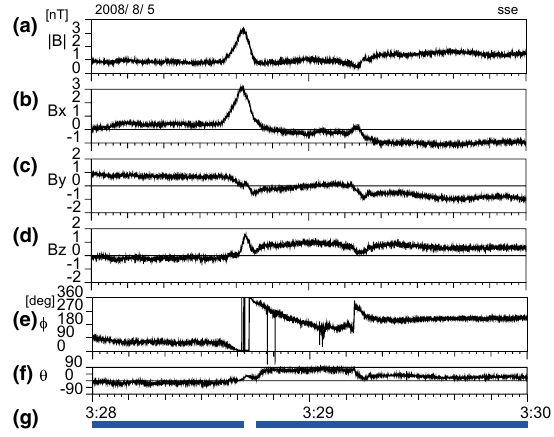
Fig. 8 High time resolution magnetic field of a hot flow anomaly on August 5, 2008. a – d The magnitude and the x SSE , y SSE , z SSE components of the magnetic field in SSE coordinates, e the azimuth and f the latitude angles observed by Kaguya at a sampling rate of 32 Hz. g Magnetic connection between Kaguya and the nightside